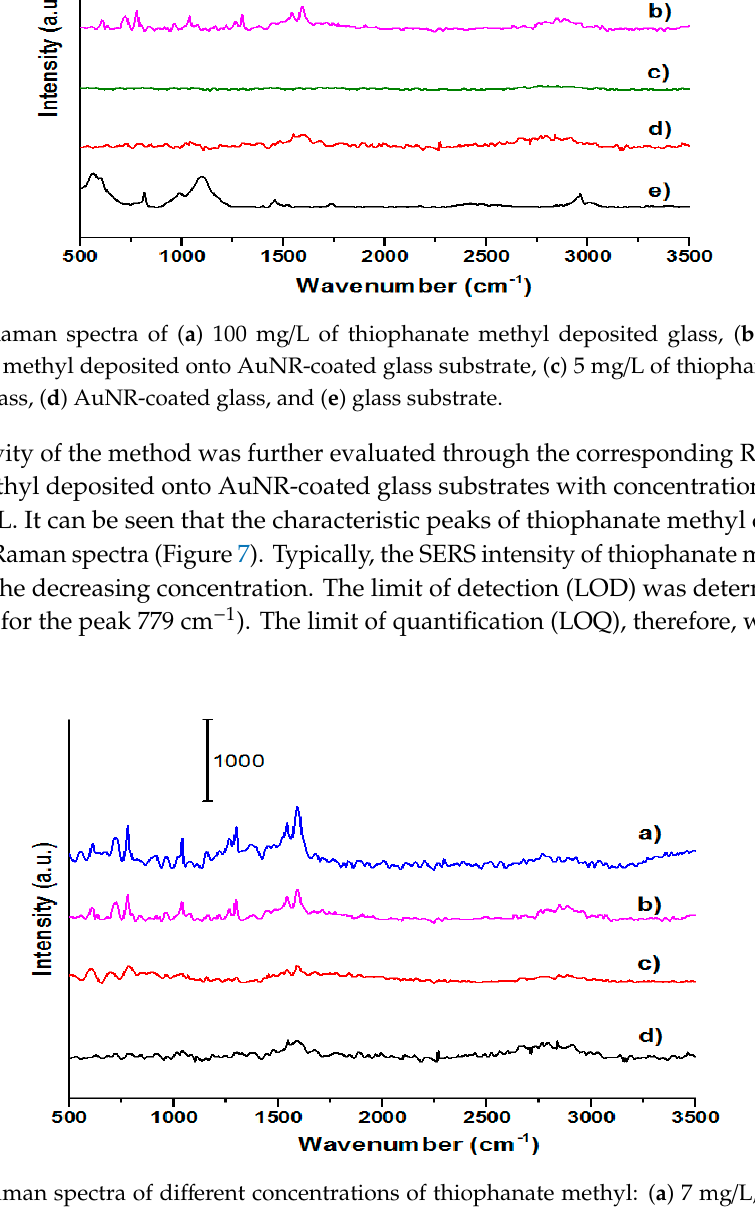
Figure 8. Raman spectra of 5 mg/L of thiophanate methyl obtained at 10 random locations on AuNR-coated glass substrate. 4. Conclusions AuNRs with a high aspect ratio and LSPR >850 nm have been successfully grown from Au nanoseeds through a facile seed-mediated method with the aid of cetyltrimethylammonium bromide and hydroquinone as a surfactant and a reducing agent, respectively, during the nanorod growth in the presence of silver ions. TEM and XRD results showed that AuNRs are single crystals with a heterogenous size distribution, and that the growth of Au nanoseeds into AuNRs took place